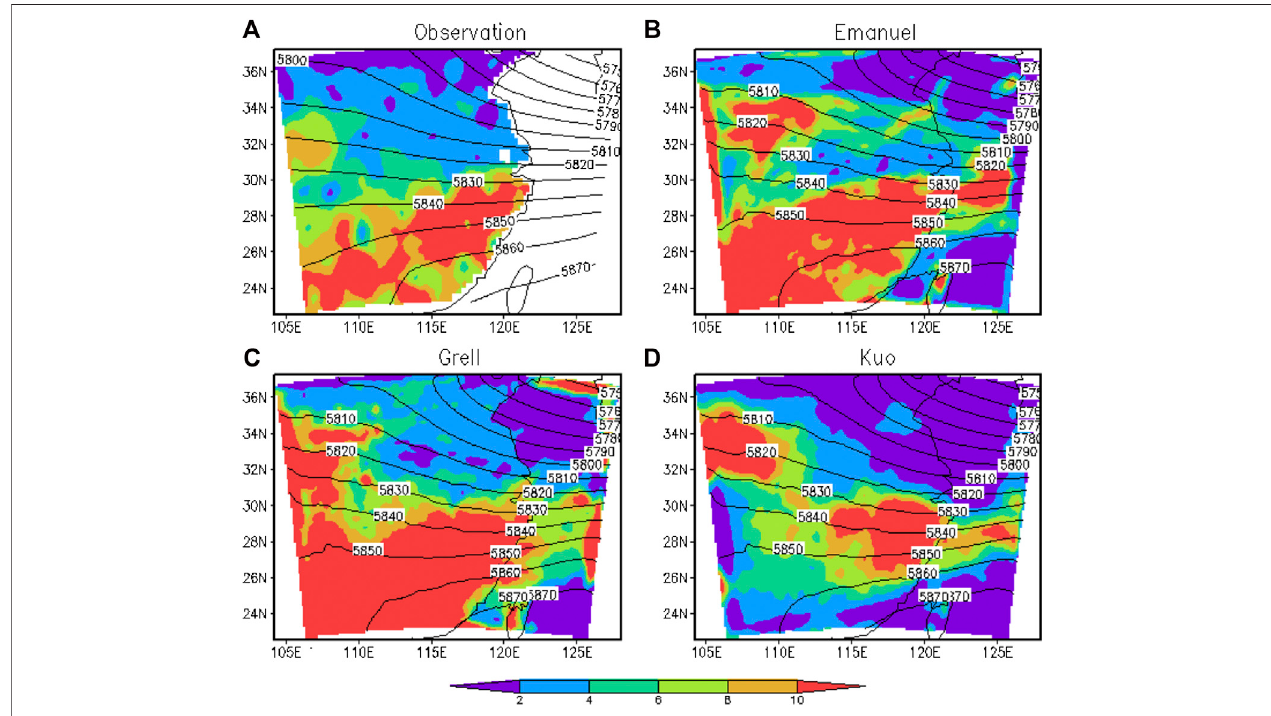
FIGURE 9 | Spatial distributions of precipitation (unit: mm/d) and 500-hPa geopotential height (unit: gpm) during the Meiyu season of 1992 from observations and simulations by the Emanuel, Grell, and Kuo schemes.